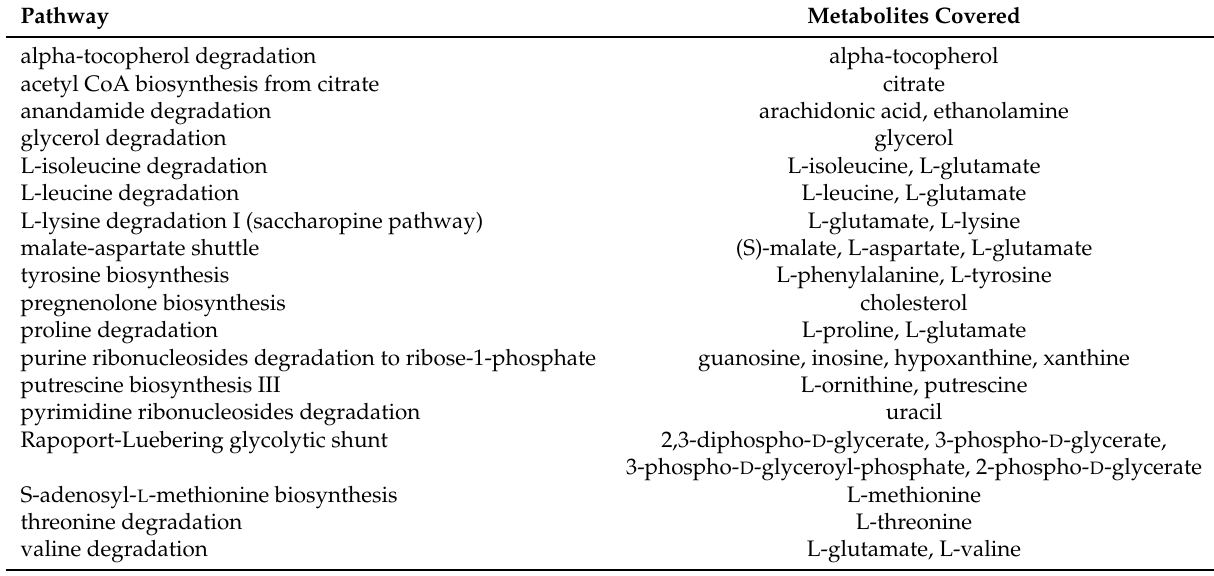
Table A2. ST000061, Pathways Occurring in All Solutions Using Pathway Size Cost